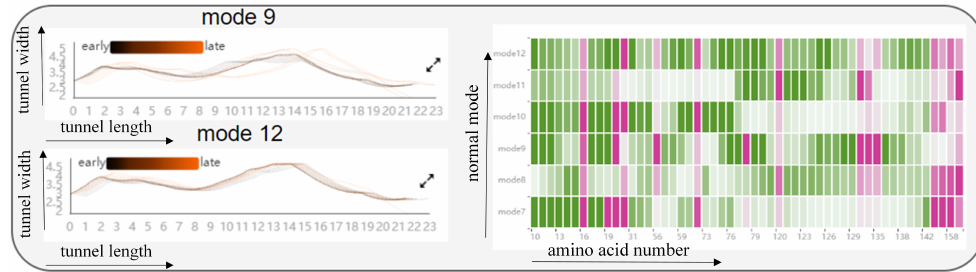
Figure 11. The graph shows the relationship between the fluctuations of amino acids around the cavity, and the radius of the cavity by means of a HeatMap and two line graphs: from the HeatMap, we can see that the fluctuations of amino acids around the cavity in mode 12 are all violent, while in mode 9, some of the amino acids around the cavity are violent and some fluctuate very little; from the two line graphs, we can observe that the cavity in mode 9 changes more significantly, while the cavity in mode 12 hardly changes at all. The black line represents the early state of the cavity and the orange line the late state of the cavity. Pink means that the amino acid is present around the cavity, and green means that it is not present around the cavity, where the shade of color represents the level of fluctuation of the amino